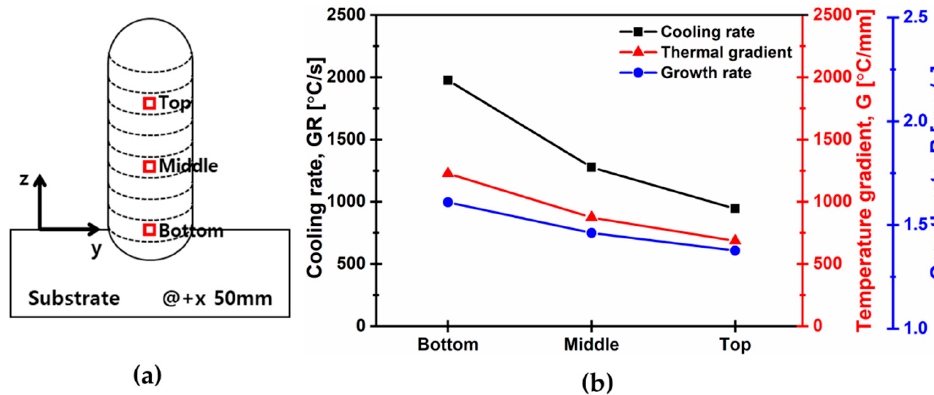
Figure 5. Solidification parameter measurement position and results; ( a ) Schematic diagram of solidification parameter measurement position; ( b ) behavior of solidification parameters and cooling rate at each position .